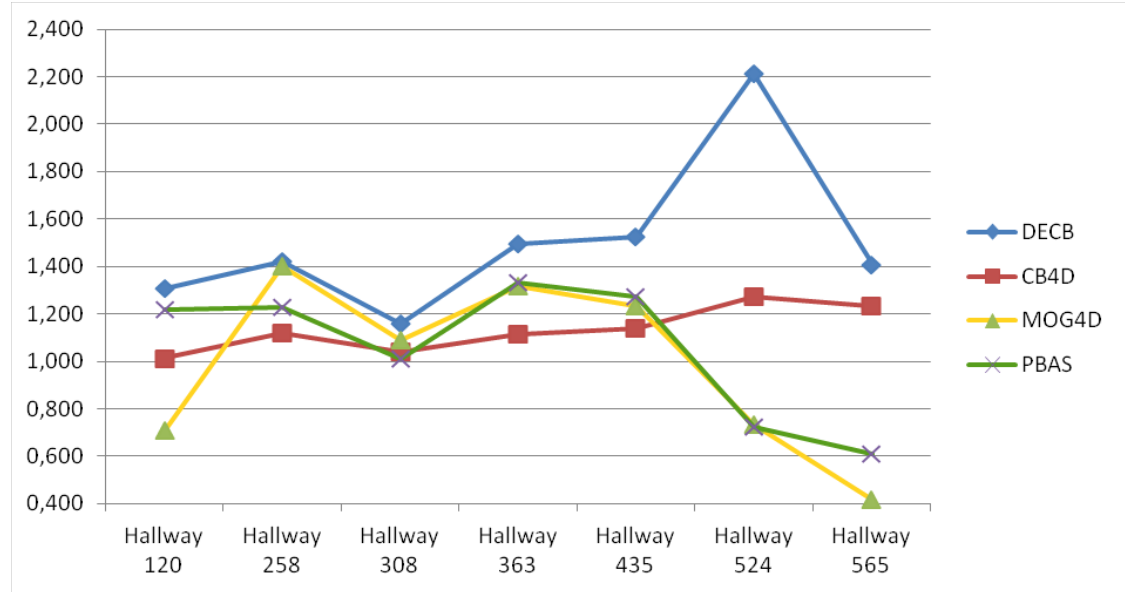
Figure 8. F gain over CB obtained from the test, 1